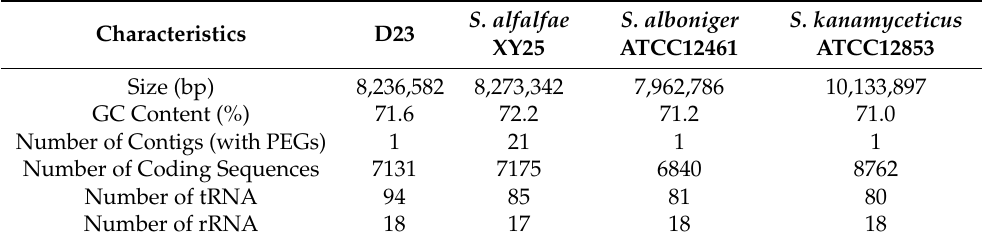
Figure 3. Circos showed that strain D23 contains (from outer to inner rings), contigs, coding sequences (CDs) on the forward strand, coding sequences (CDS) on the reverse strand, coding sequences of S. alfalfae XY25, S. kanamyceticus ATCC12853 and S. alboniger ATCC12461, GC skew, and GC content. Table 2. General genome feature of S. huasconensis D23, S. alfalfae XY25, S. alboniger ATCC12461, and S. kanamyceticus ATCC12853.